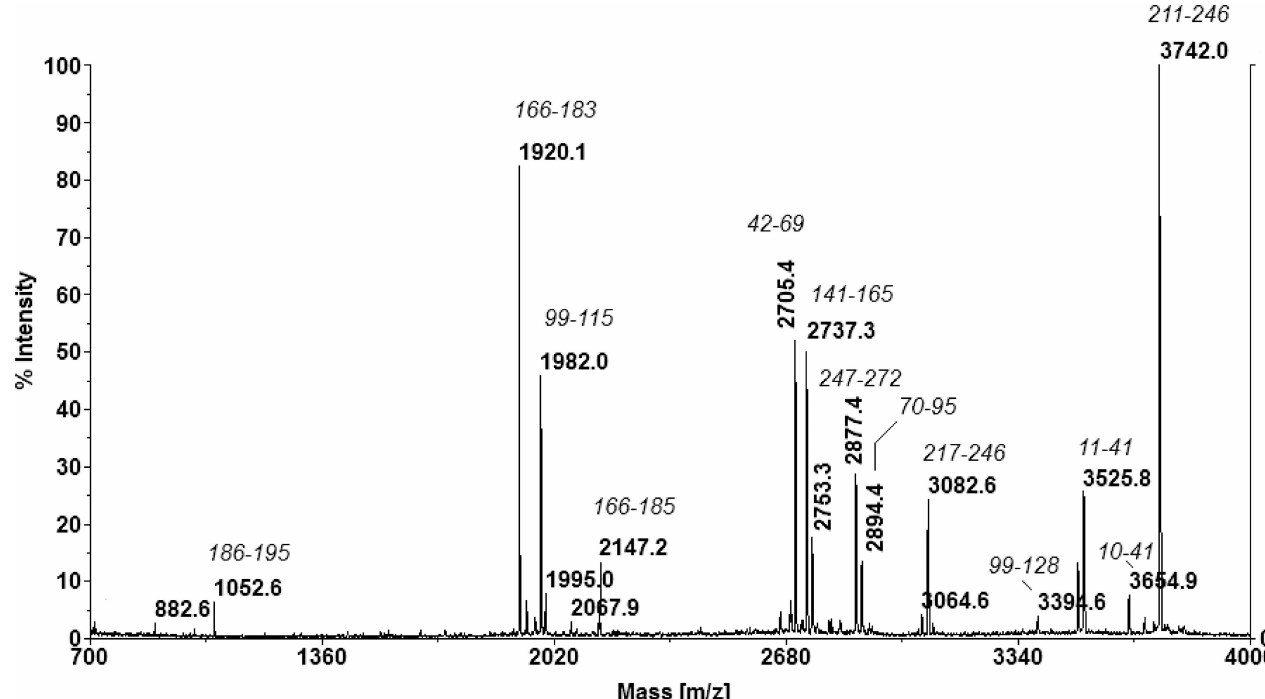
Fig 8. Maldi ToF—MS-MS mapping of MDH. Signals are assignedthrough the position within the protein as presentedin italics.